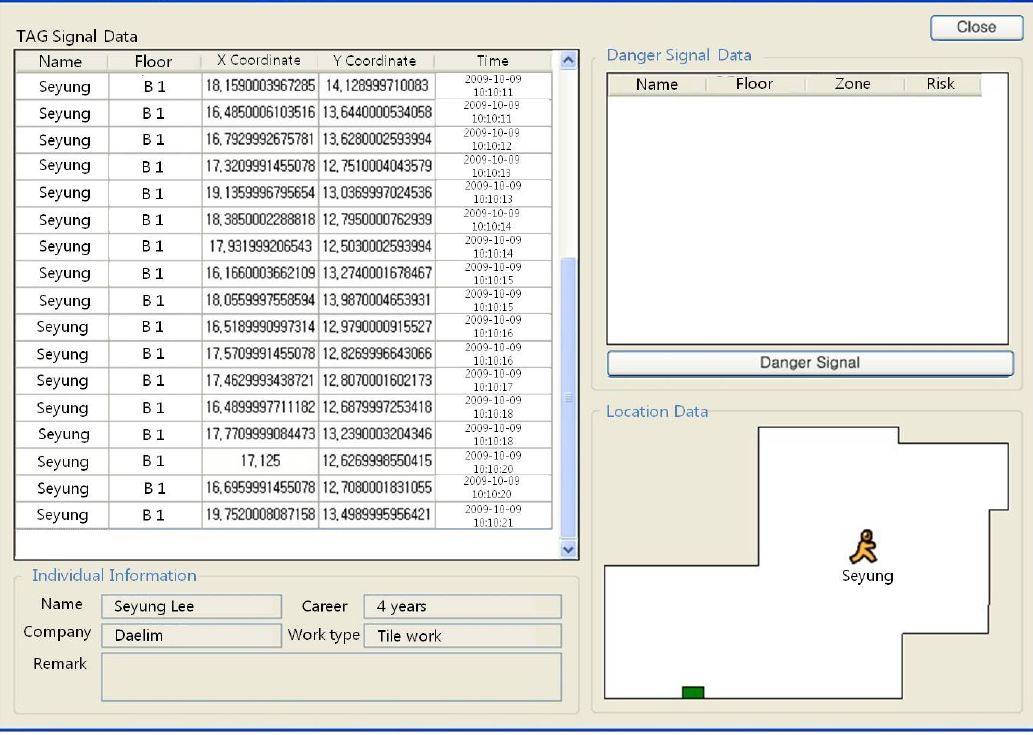
Fig. 5. Monitoring performance under a LOS environment